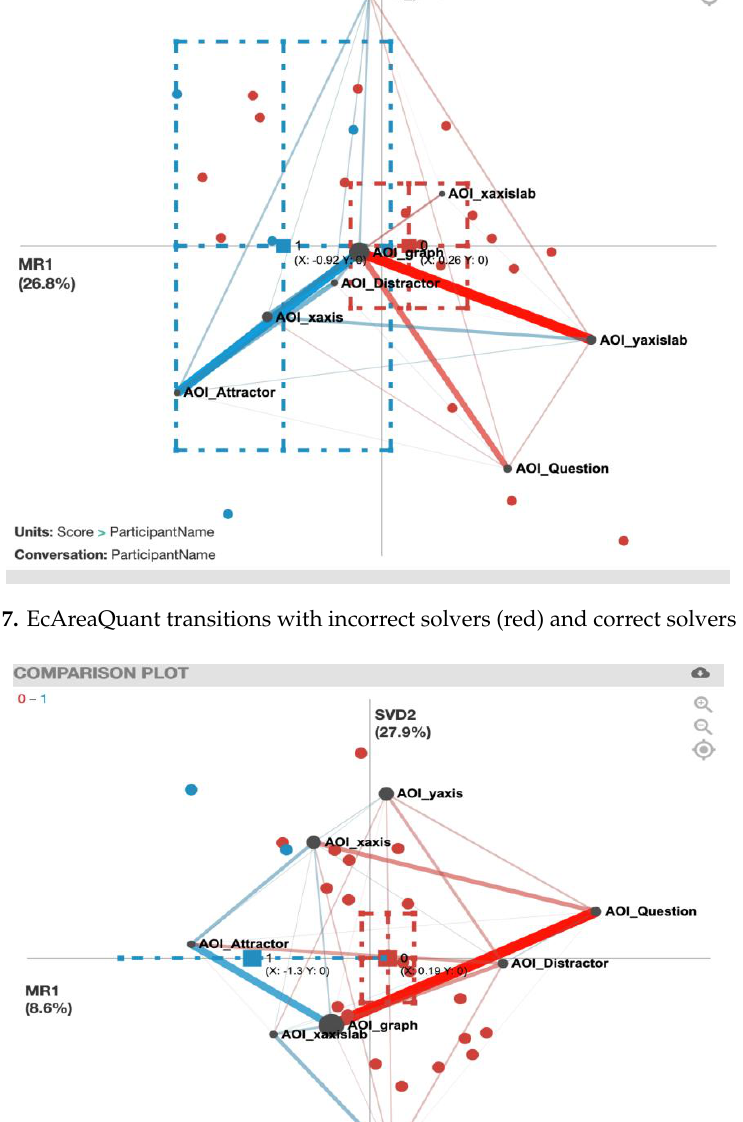
20 of 32 AOI_Attractor for correct solvers (blue). For a summary of the strong gaze transition correlations, see Table 6.